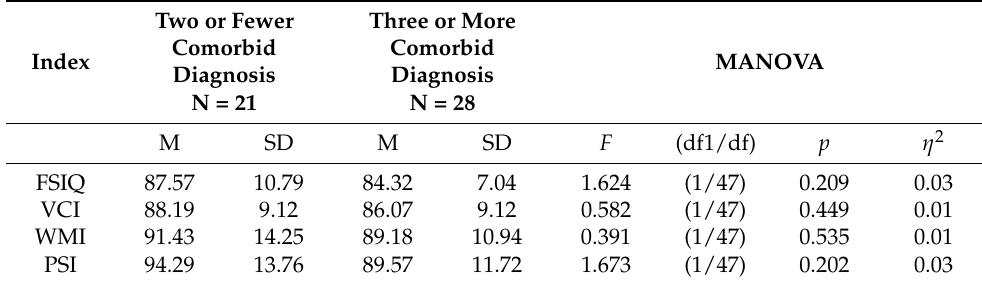
Table 6. Differences in the index means between patients with one or two comorbid diagnoses or three or more diagnoses and results of